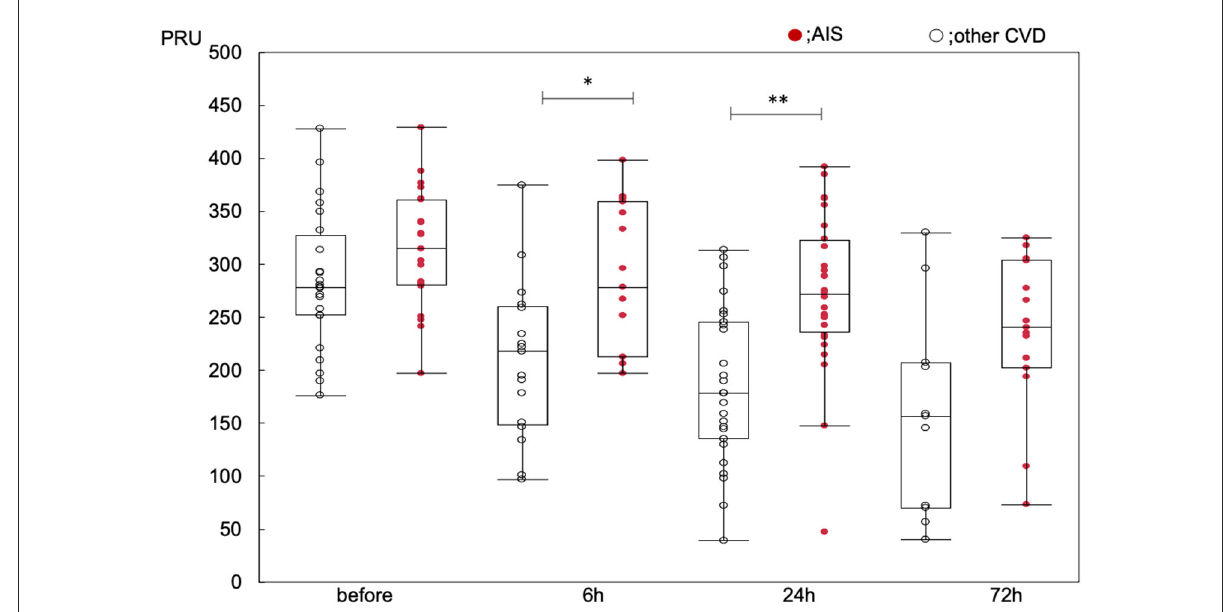
FIGURE2 Changes to PRU value over time. * p < 0.05, ** p < 0.01, compared within the groups at each